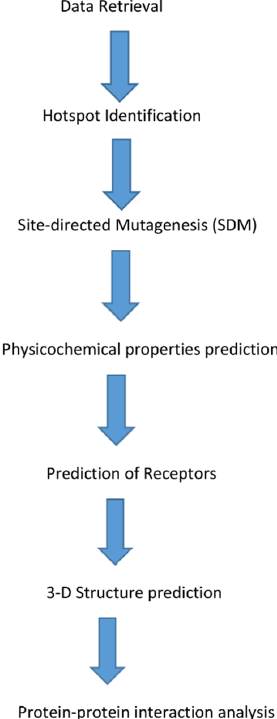
Figure 2. Schematic diagram of the processes involved in predicting derivative antimicrobial pep ‐ tides (AMPs).